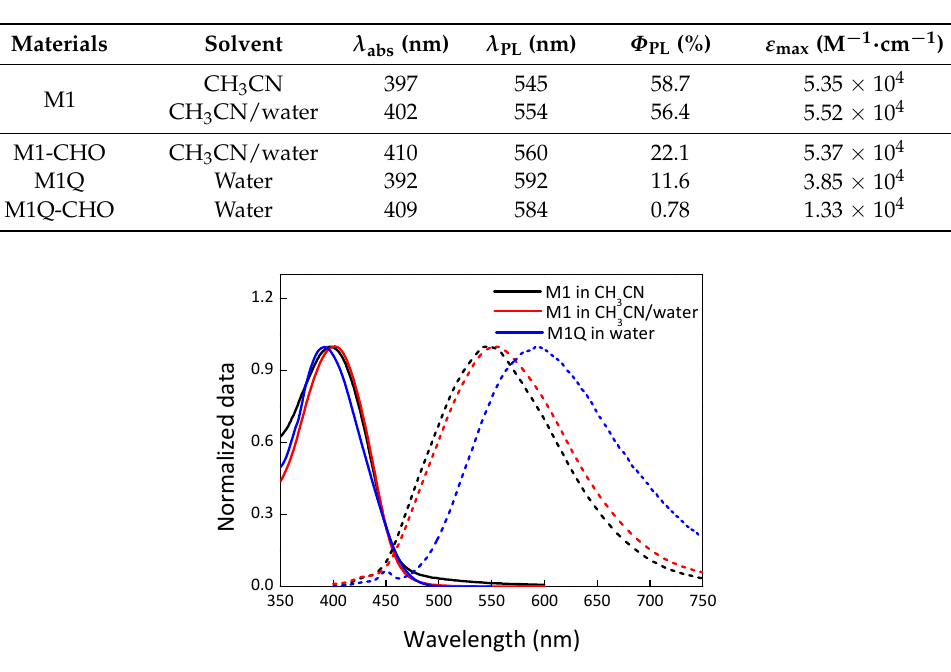
Table 1. Optical properties of M1, M1-CHO, M1Q, and M1Q-CHO.